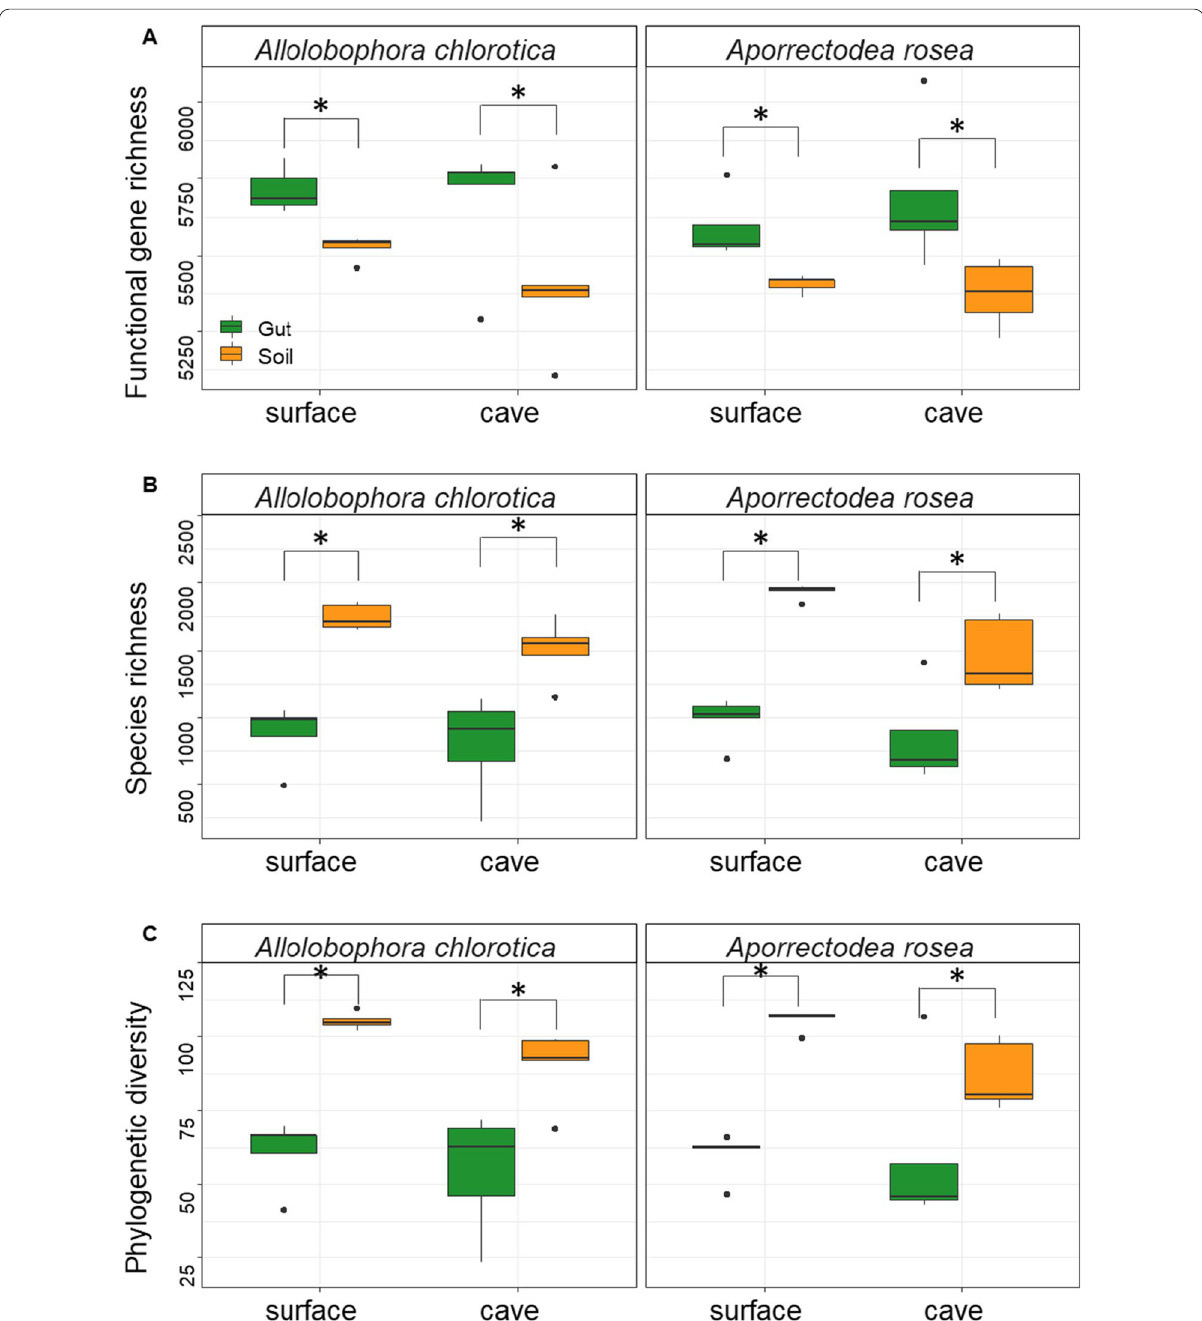
Fig. 2 Functional ( A ), taxonomic ( B ) and phylogenetic ( C ) diversities of bacterial communities in the soil and gut of earthworms present in caves and the